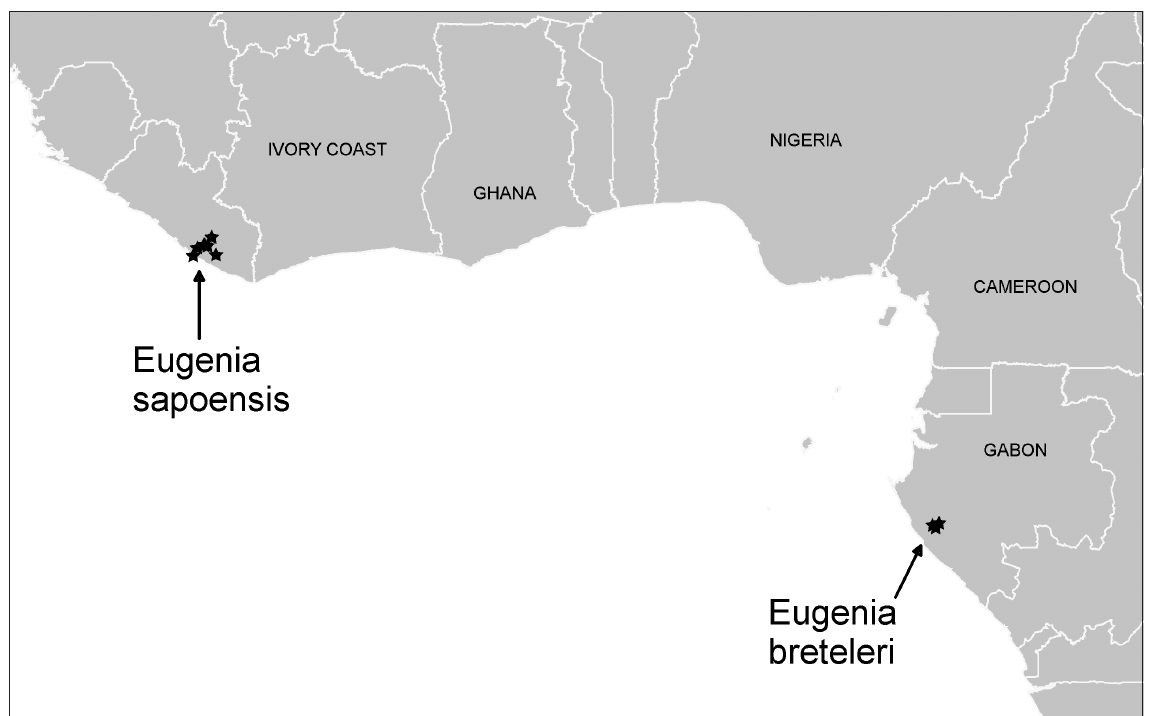
Fig. 3. Distribution map of Eugenia sapoensis sp. nov. and Eugenia breteleri sp.